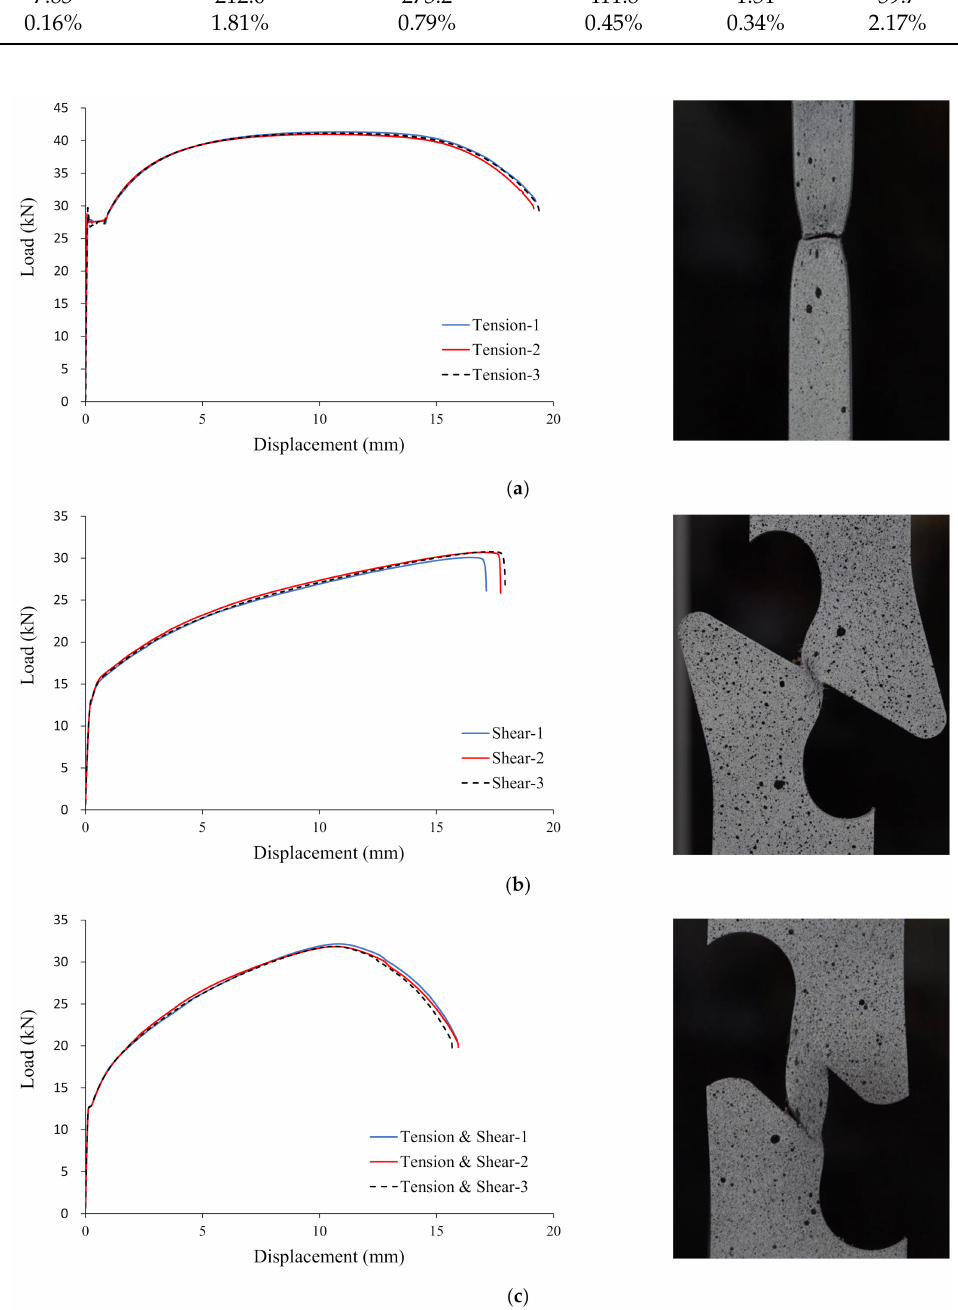
Figure 3. Experimental load–displacement curves and fracture modes: ( a ) Uniaxial tension specimen; ( b ) In-plane shear specimen; ( c ) Tension and shear